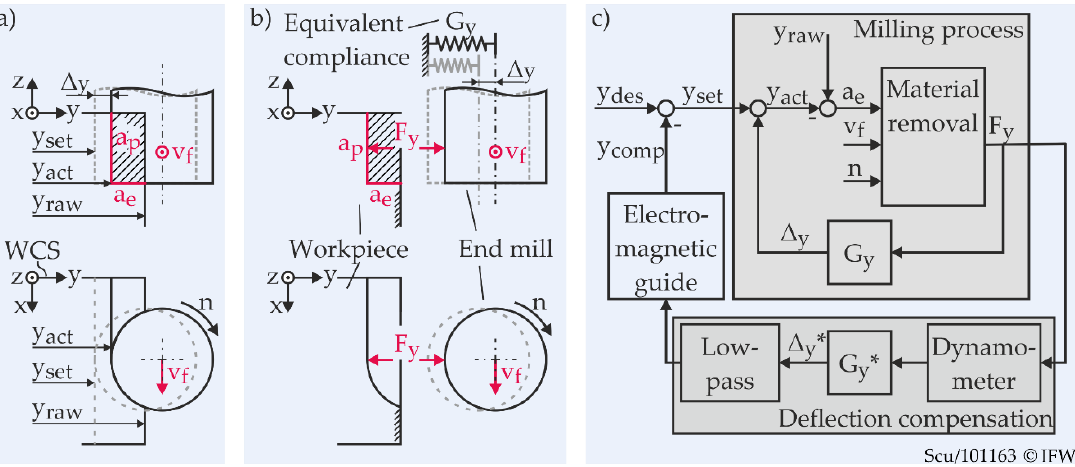
Figure 3. ( a ) End mill engagement in flank-milling process. ( b ) Free body diagram. ( c ) Simplified model of milling process with deflection compensation.